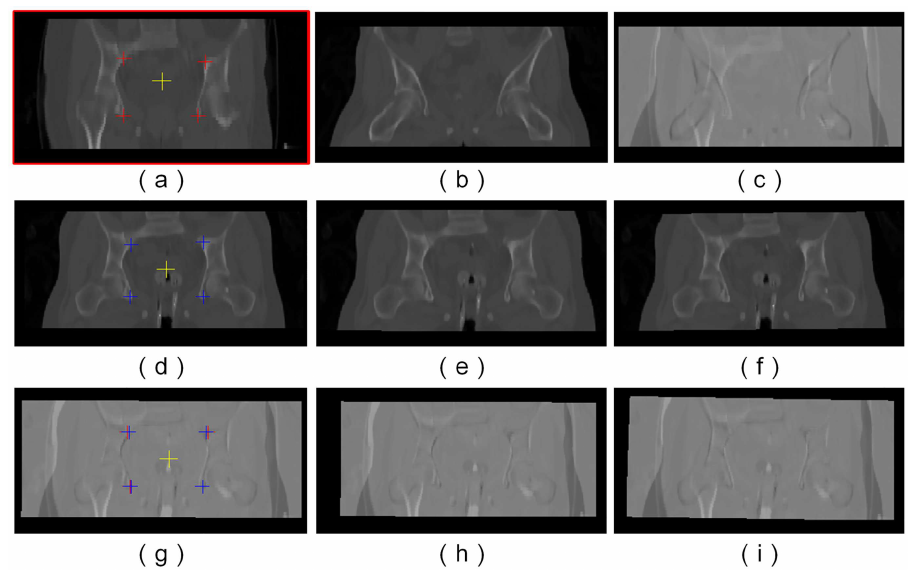
Fig 8. Coarseregistration between EBRT and HDR-BT CT images for better initialization. (a) EBRT images used as a reference. (The four marked points inside the image were used for point set rigid registration.) (b) HDR-BT image before initialization.(c) Differenceimages betweenEBRT and HDR-BT before initialization. (d) HDR-BT image with four marked points used for point set rigid registration.(e) HDR-BT image after intensity-based rigid, and affine (f) registration.The correspondingdifference images betweenEBRT and HDR-BT after point set rigid, intensity-based rigid, and affine registrationare shown in